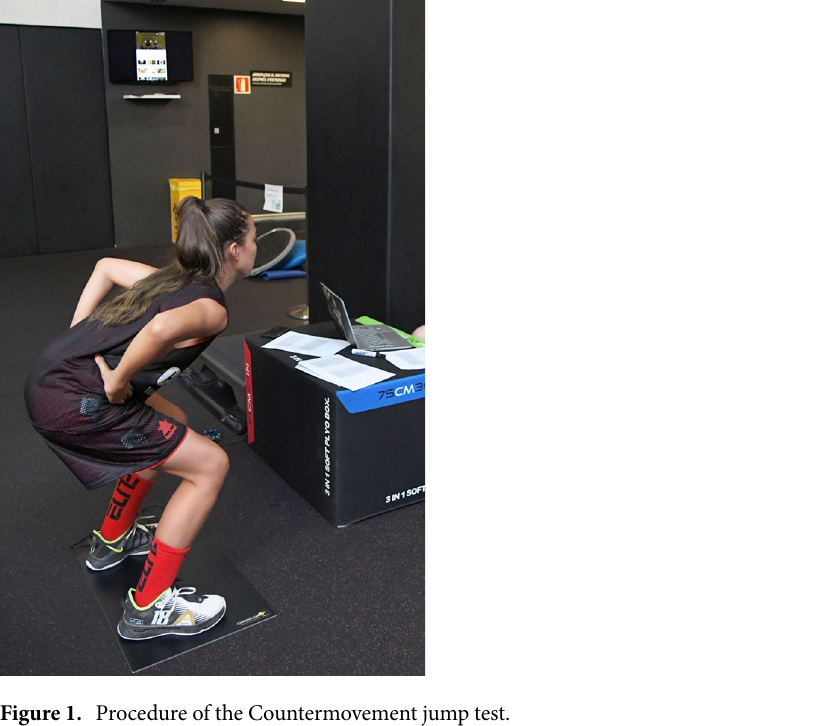
Figure 1. Procedure of the Countermovement jump